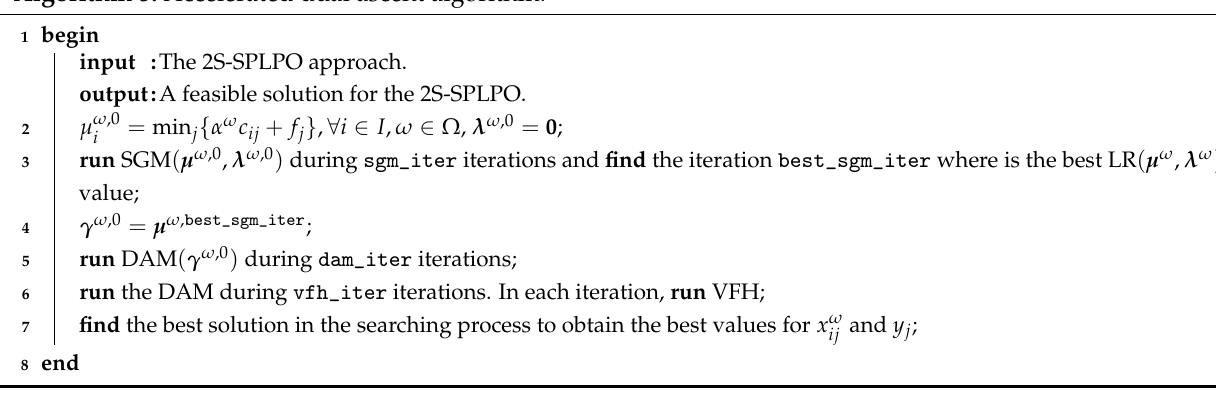
Algorithm 5: Accelerated dual ascent algorithm.